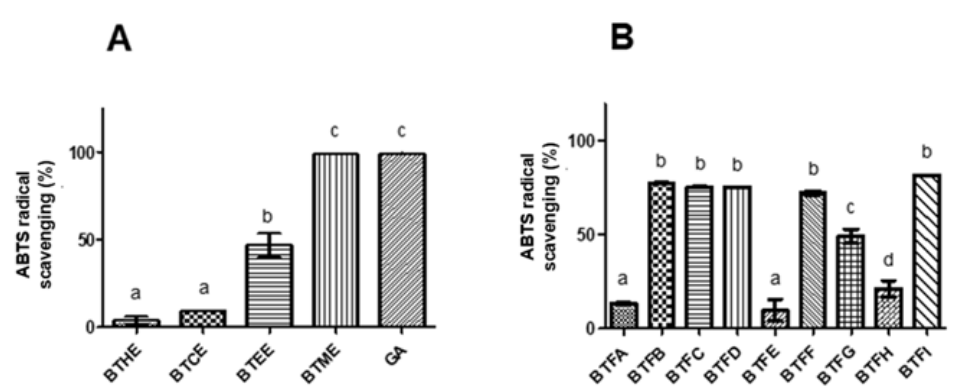
Figure 1. Comparative evaluation of antioxidant activity by the ABTS assay of the crude extracts ( A ) and fractions ( B ) of Buchenavia tetraphylla leaves. BTHE: hexane extract; BTCE: chloroform extract; BTEE: ethyl acetate extract; BTME: methanolic extract; BTFA: Fraction A; BTFB: Fraction B; BTFC: Fraction C; BTFD: Fraction D; BTFE: Fraction E; BTFF: Fraction F; BTFG: Fraction G; BTFH: Fraction H; BTFI: Fraction I. In each graph, values with significant differences ( p < 0.05) are indicated by different superscript letters ( a, b, c ). The results are expressed as the mean ± standard deviation calculated from three independent assays performed in triplicate ( n = 3 ).